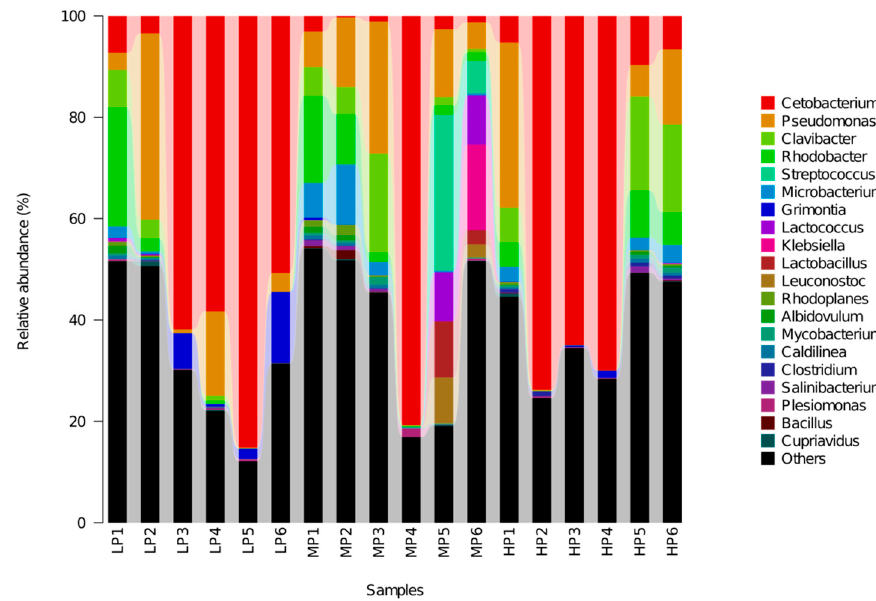
Figure 3. Relative abundance of intestinal bacterial communities at the genus level.